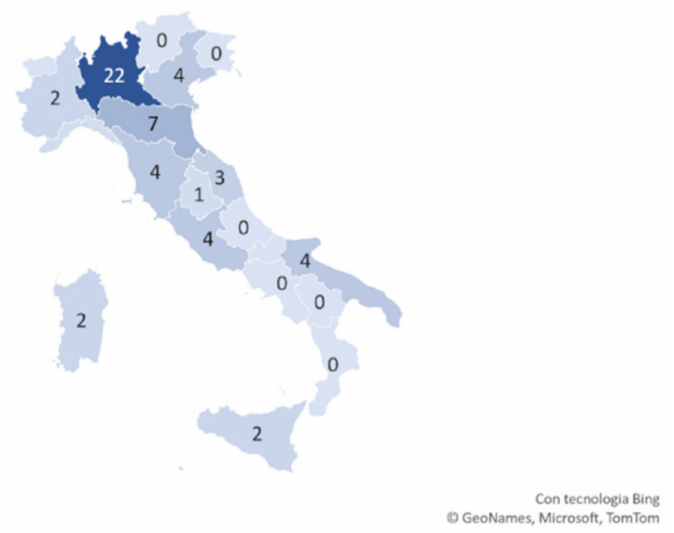
Figure 1. Distribution of families that responded to the